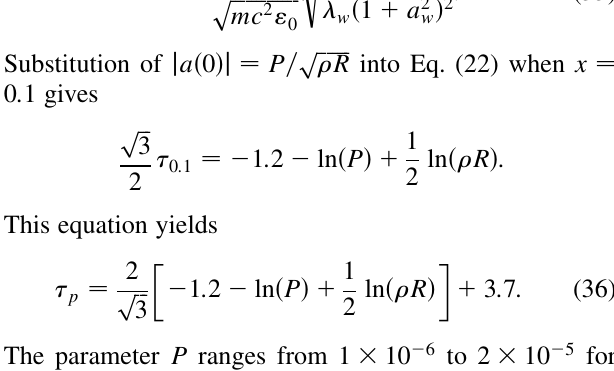
FIG. 6. (Color) Electron distributions in a phase plane of (cid:1)